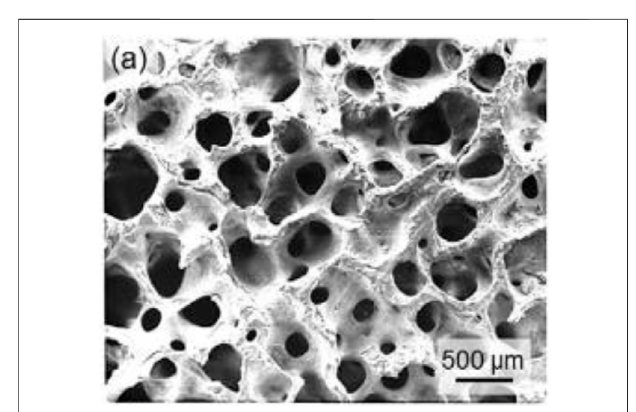
FIGURE 6 | Ceramic orbital implants: (A) SEM micrograph of a Molteno M-Sphere. Reproduced with